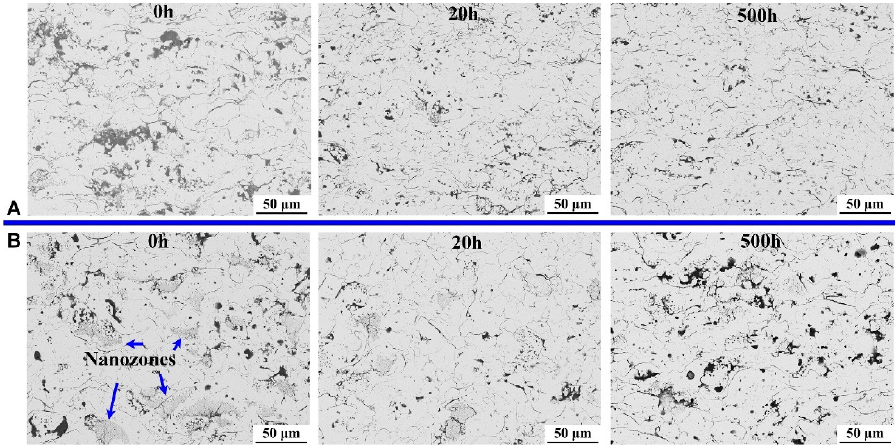
Figure 44. Global structural evolution during thermal exposure: ( A ) conventional TBCs ( B ) nanostructured TBCs [233].